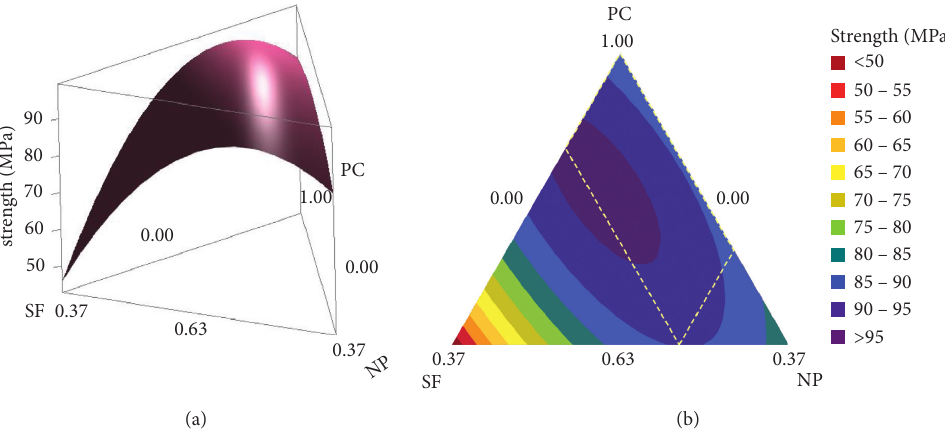
Figure 8: Strength isoresponse of concrete that incorporates a blend of binders ( ( w / b ) � 0.25). (a) Surface. (b)